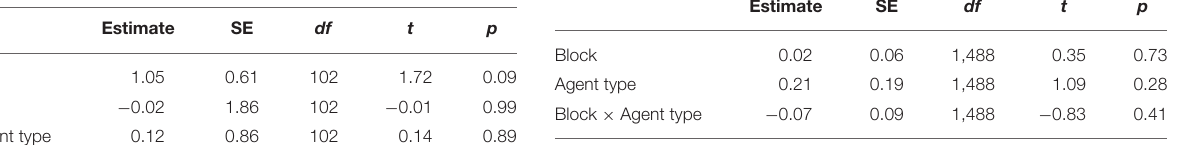
TABLE 1 | LME analysis on points